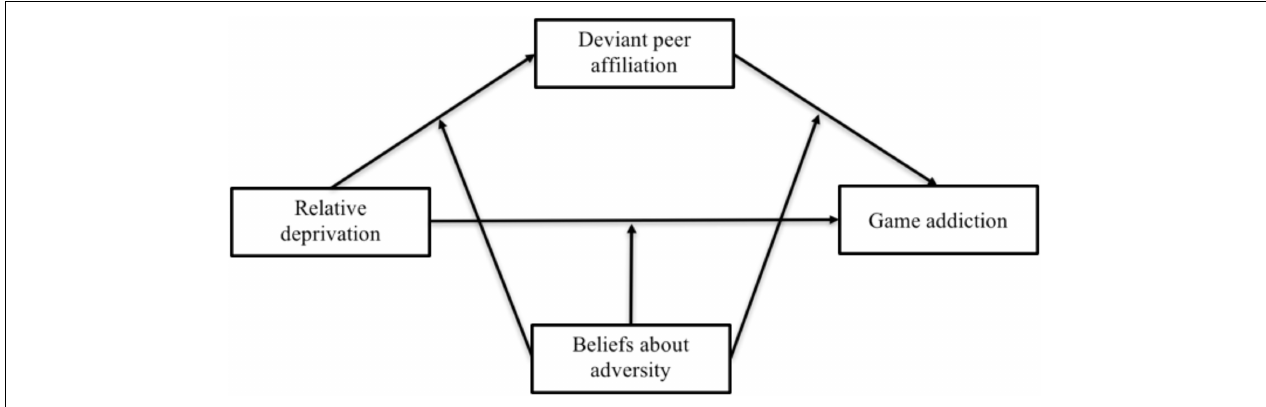
FIGURE 2 | The moderated mediation model.